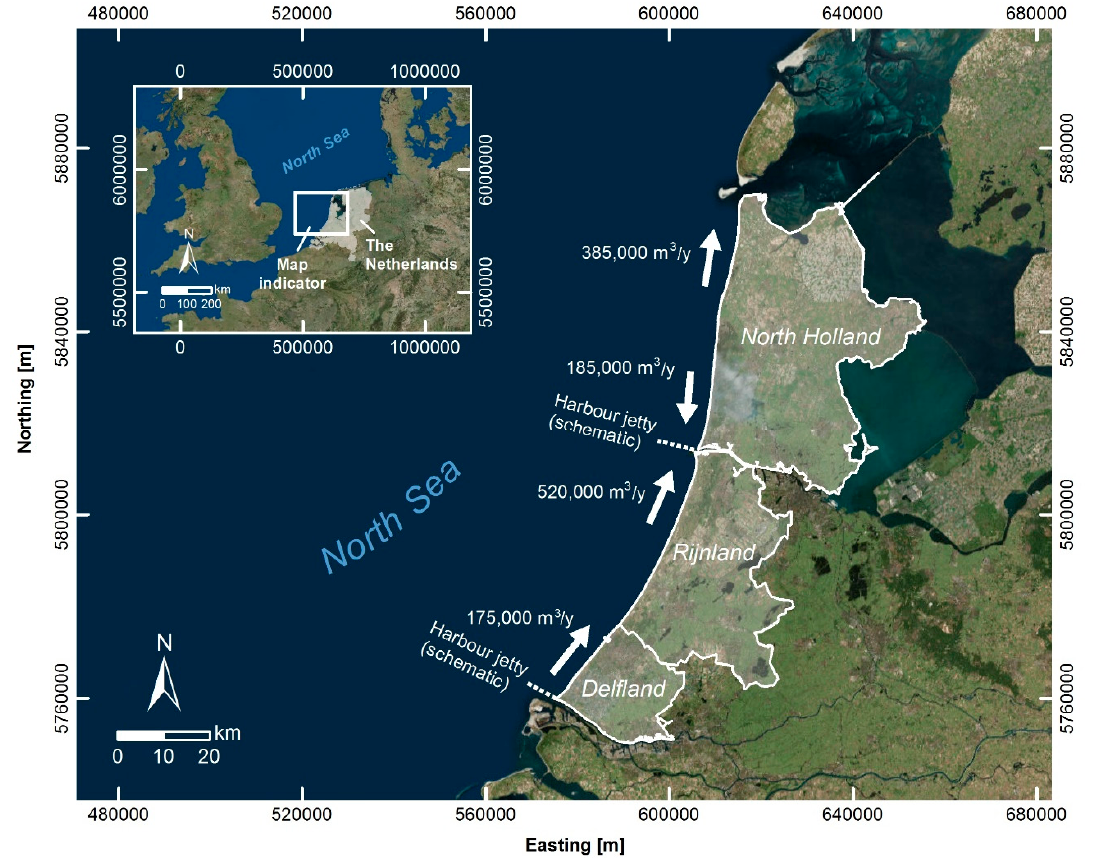
Figure 1. Map of Holland, the Netherlands, including the three subregions considered in this study: Delfland, Rijnland, and North Holland. Net yearly alongshore sediment transport rates are also shown [24].